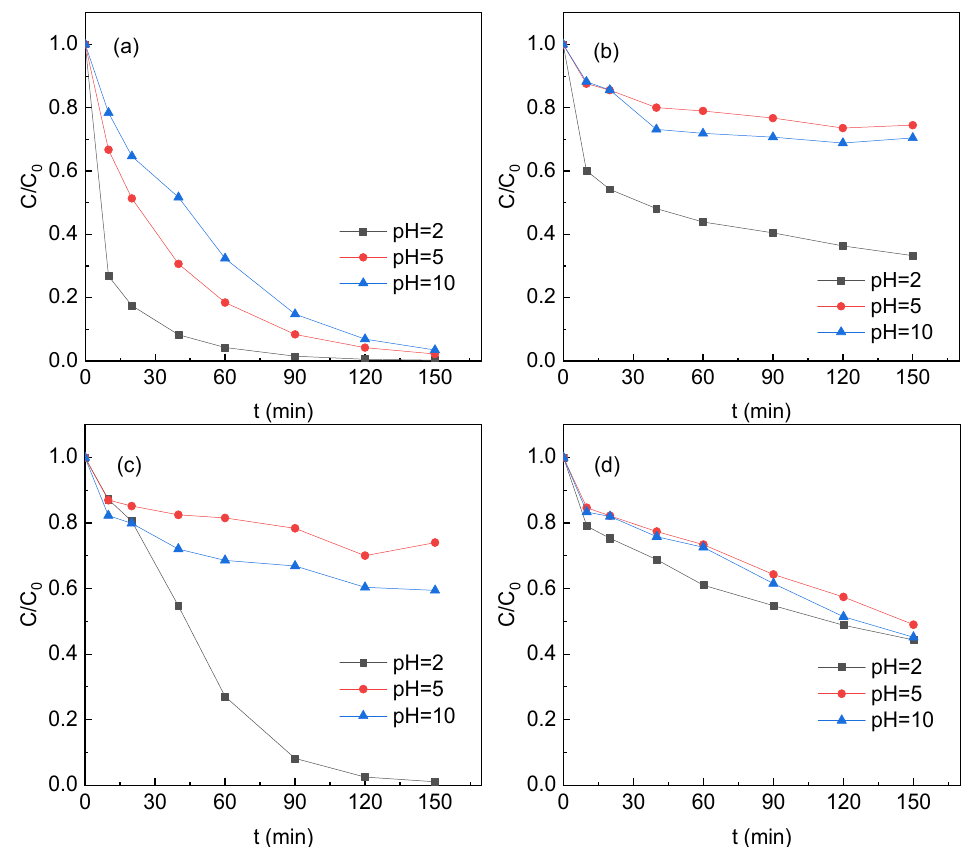
Figure 6. SMT removal at different pH ( a ) S1, ( b ) S2, ( c ) S3 and ( d ) S4. Reaction conditions: [SMT] 0 = 5 mg/L, [PS] 0 = 4 mM, [TM] 0 = 5 g/L, and T = 25 °C. ( a ) was drawn with modification after Zhang et al. [8].